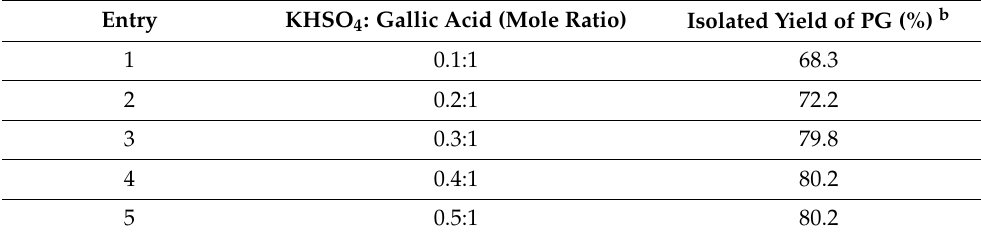
Purity was confirmed by TLC and melting